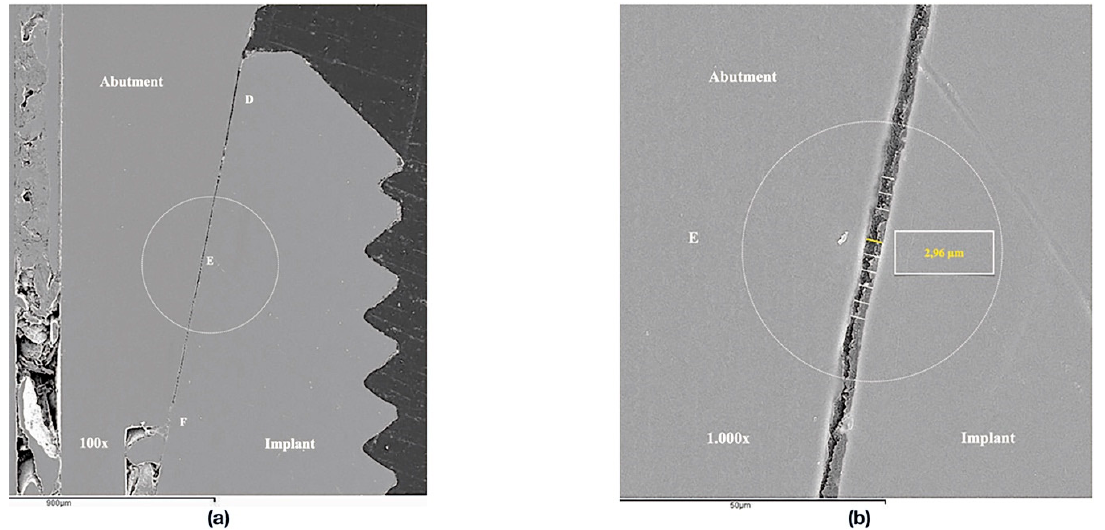
Figure 3. SEM images (1000×): ( a ) Reference points for the measurements in the Morse taper connection. ( b ) Detail of an edited image increasing the number of measurements per point.